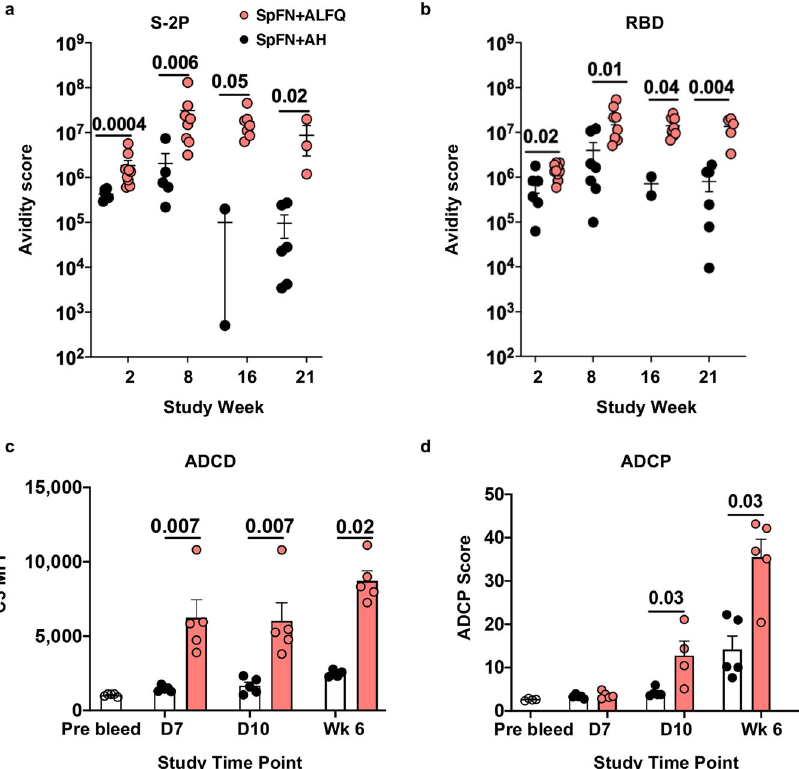
Fig. 7 SpFN + ALFQ vaccine-induced antibody avidity maturation and Fc effector functions. Serum from C57BL/6 mice vaccinated (Fig. 5d) with SpFN + ALFQ or SpFN + AH ( n = 5-10 for each group) was assessed for antibody avidity and antibody Fc effector functions. a Surface plasmon resonance data showing S-2P protein-speci fi c and b RBD protein-speci fi c antibody avidity score (Response Unit/Kd off rate) at weeks 2, 8, 16, and 21. c Antibody-dependent complement deposition (ADCD) and d Antibody-dependent cellular phagocytosis (ADCP) activities on days 7, 10 and week 6. Data were graphed as Mean ± SEM. The statistical differences between the two vaccinated groups were evaluated by Mann – Whitney U -test using the GraphPad Prism version 9 with P ≤ 0.05 considered as signi fi